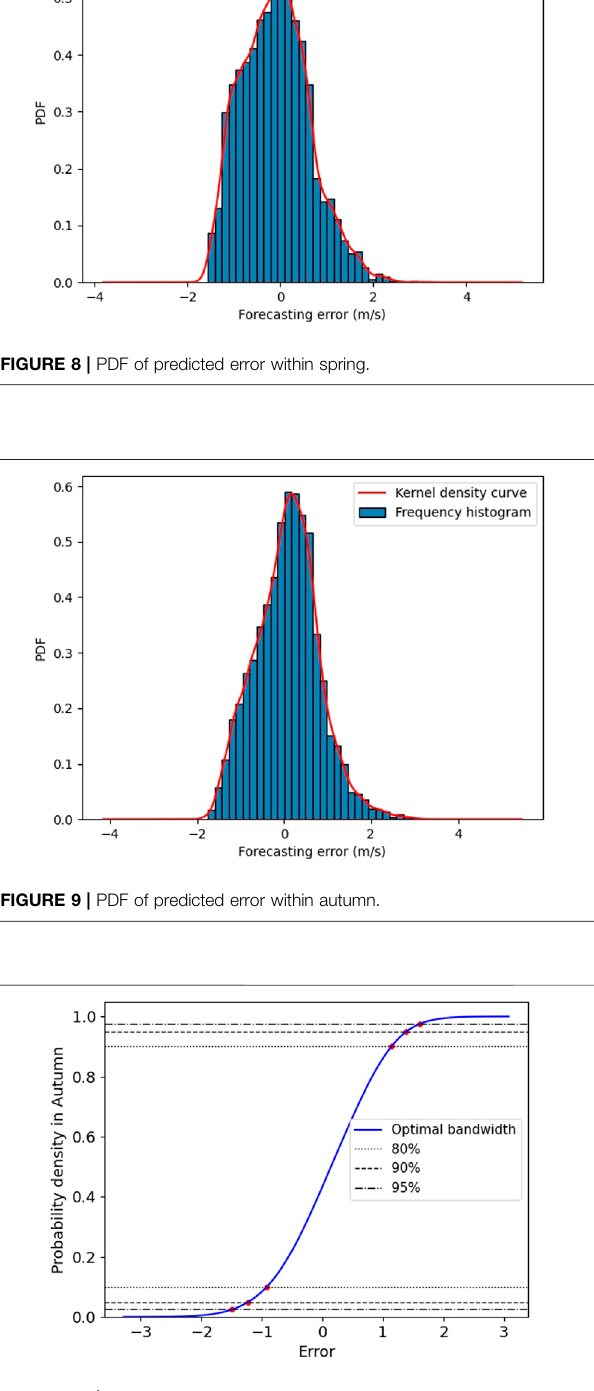
FIGURE 10 | CDF of predicted error within